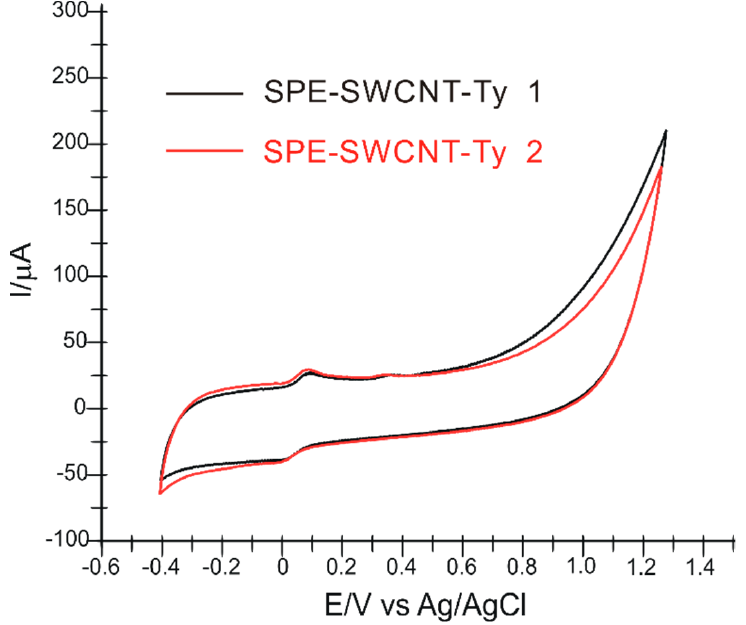
Figure 11. CVs recorded by two biosensors prepared identically (almost simultaneously) immersed in a solution of HT 10 − 4 M, scan rate 0.1 V × s − 1 .